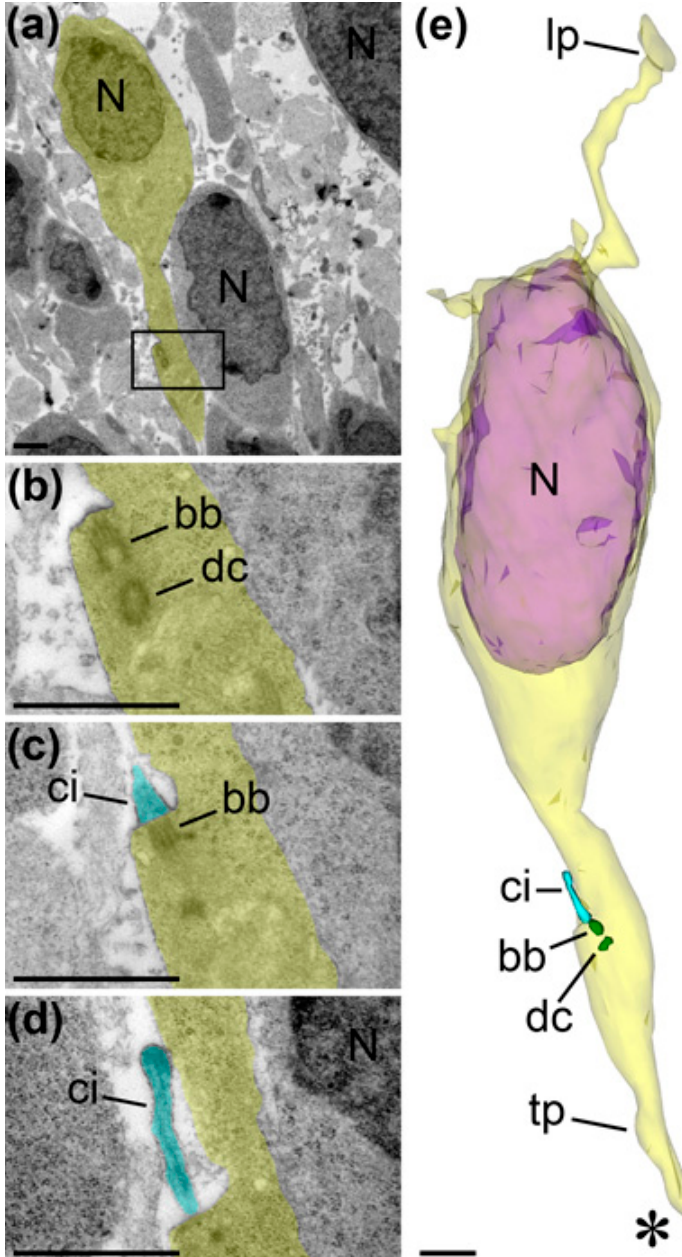
Figure 7. Selected serial electron microscopy images and 3D reconstruction of a postmitotic cell (also shown in Figure 10 as cell R8) from SVZ of E45 rhesus macaque. The images are placed with pia-directed segment up and the segment facing ventricular surface down. Cell body and processes are shown as semitransparent yellow, and the nucleus is semitransparent violet. Framed area in ( a ) is enlarged in ( b ) and further followed in serial images ( c , d ). Cilium (ci; depicted light blue) in the apical process designates that the cell is disconnected from the ventricular surface and can initiate vertical migration. Basal body (bb) and daughter centriole (dc) are depicted green in 3D reconstruction. Terminated end of the apical process is indicated with asterisk. Abbreviations: lp, leading process; N, cell nucleus; tp, trailing process. Scale bars: 1 μ m.